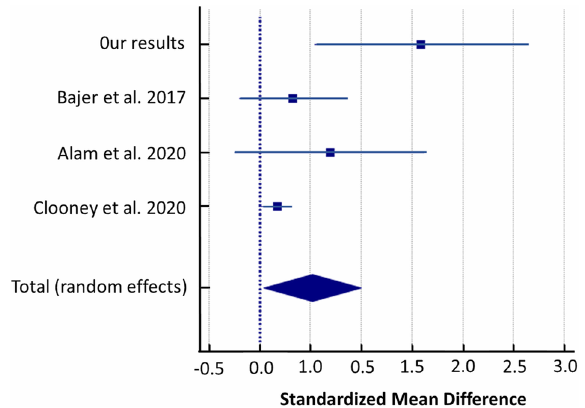
Figure 10. Forest plot of random-effects meta-analysis including studies evaluating the abundance of Anaerostipes in UC patients versus healthy controls.